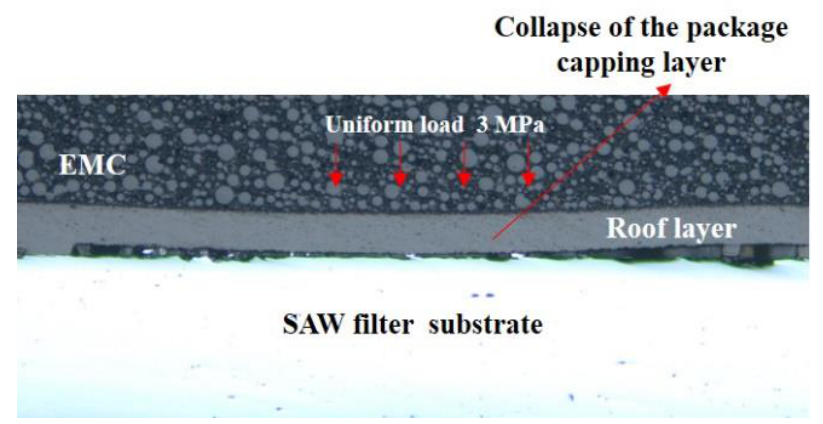
Figure 5. Collapse of the SAW WLP package.